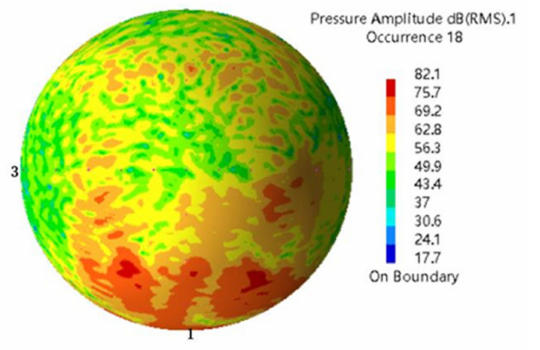
Figure 11. Spherical sound pressure cloud